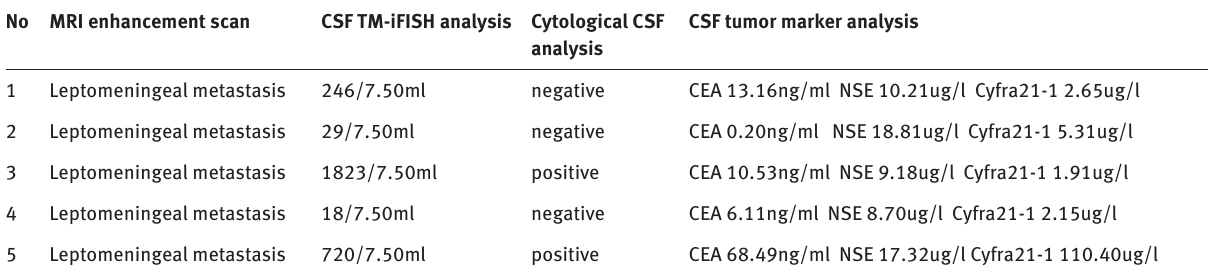
No MRI enhancement